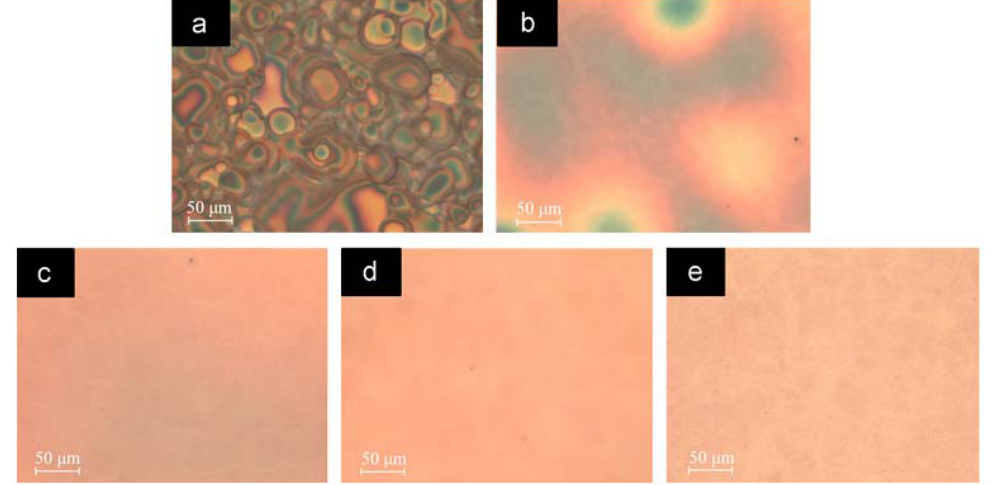
Figure 12. Optical images of sprayed film subjected to a range of hot solvent vapour (HSV)-annealing processes: ( a ) as-sprayed film; ( b ) HSV-annealed film at 45 °C for 2 min; ( c ) HSV-annealed film at 45 °C for 4 min; ( d ) annealed film at 55 °C for 2 min; and ( e ) HSV-annealed film at 55 °C for 4 min. Reprinted with permission from Elsevier